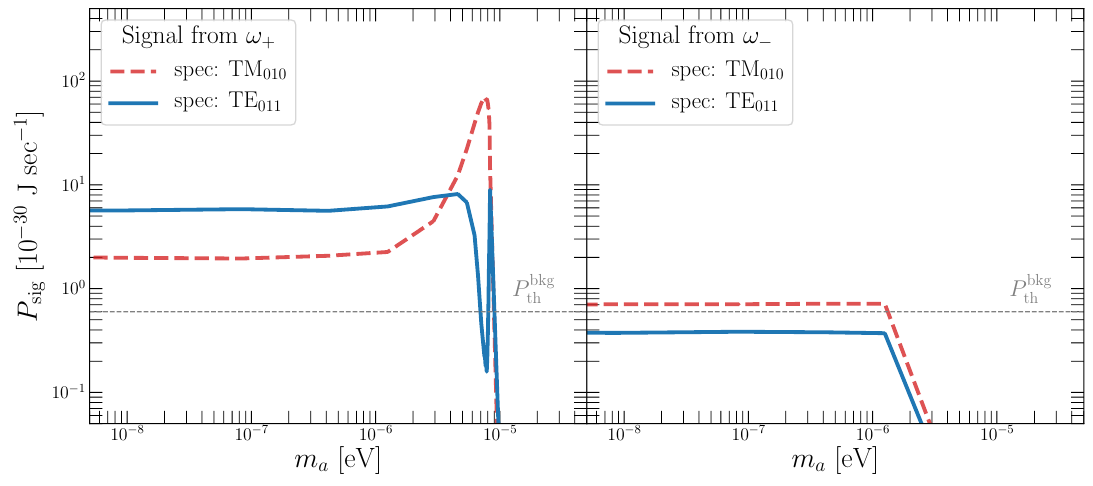
Figure 4 . Comparisons of signal power, assuming g aγ = 5 × 10 − 11 GeV − 1 , E peak = 80MV / m , Q 1 = 10 10 . ω ± = ω 011 ± ω 010 . The red and blue lines correspond to the two setups in figure 3. Also TE TM shown is the thermal background (grey) equal to k B T ∆ ω 1 assuming the system is cooled down to 1 . 4 K and ∆ ω 1 = year − 1